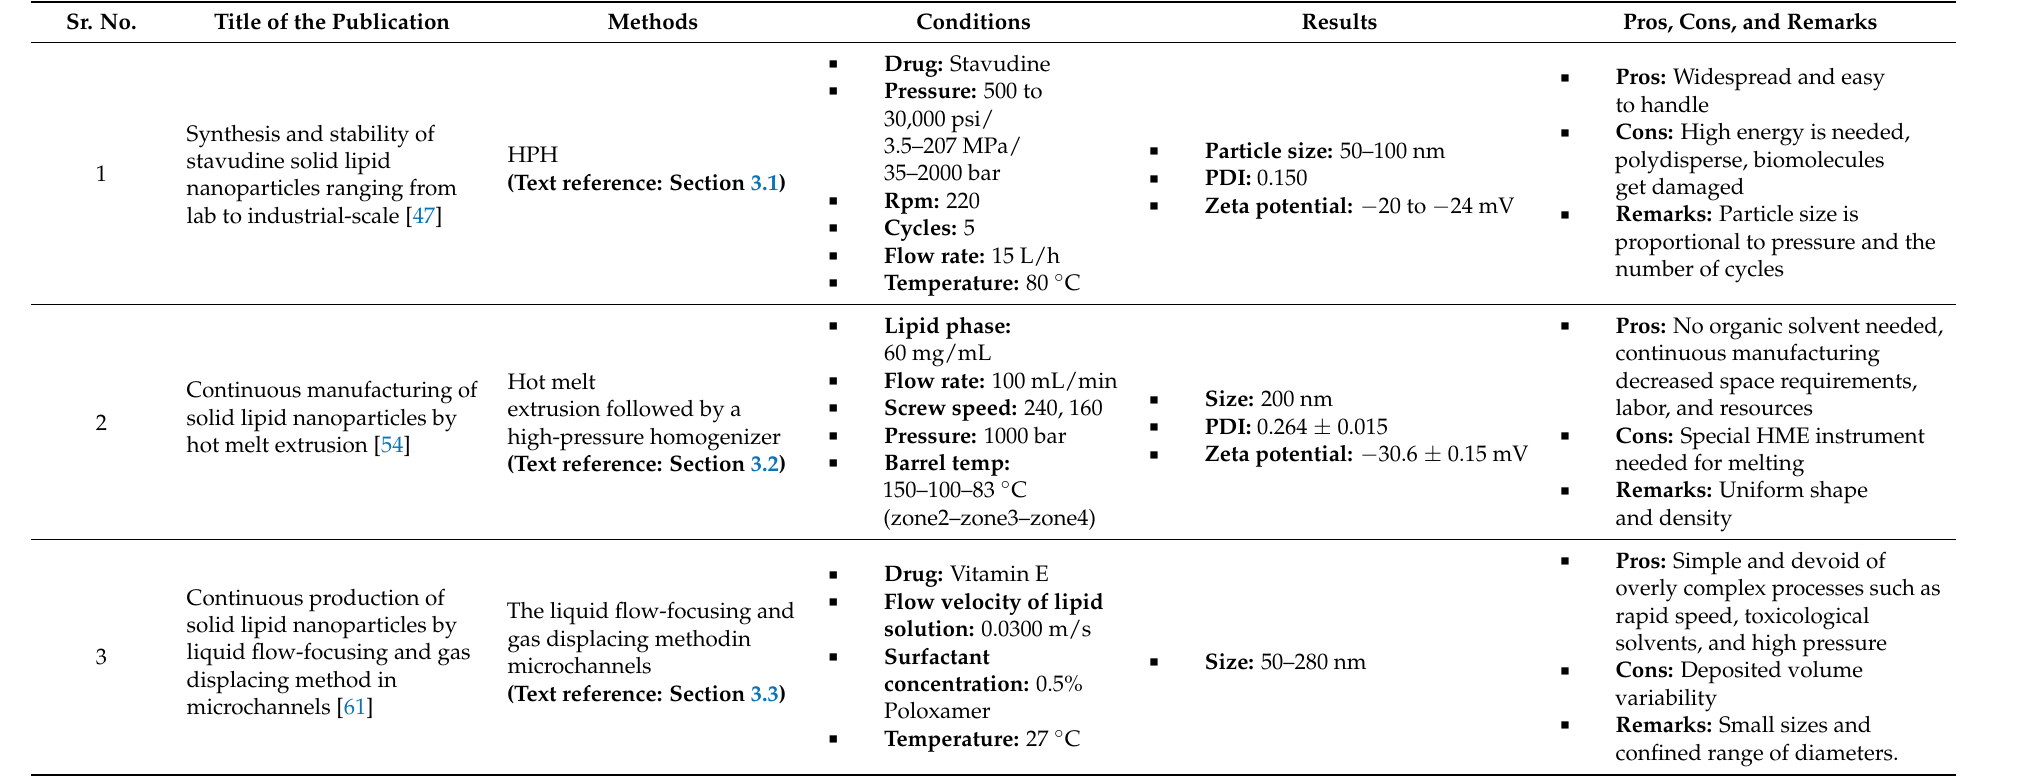
Table 1. Summary of the scale-up methods of solid lipid nanoparticles.